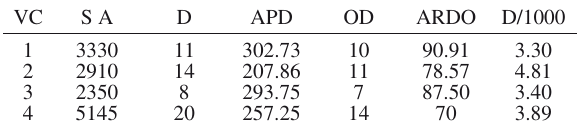
Table 1. – Visual survey data for O. vulgaris in the Rodas inlet. VC, visual census number; SA, swept area (m 2 ); D, average depth (m);